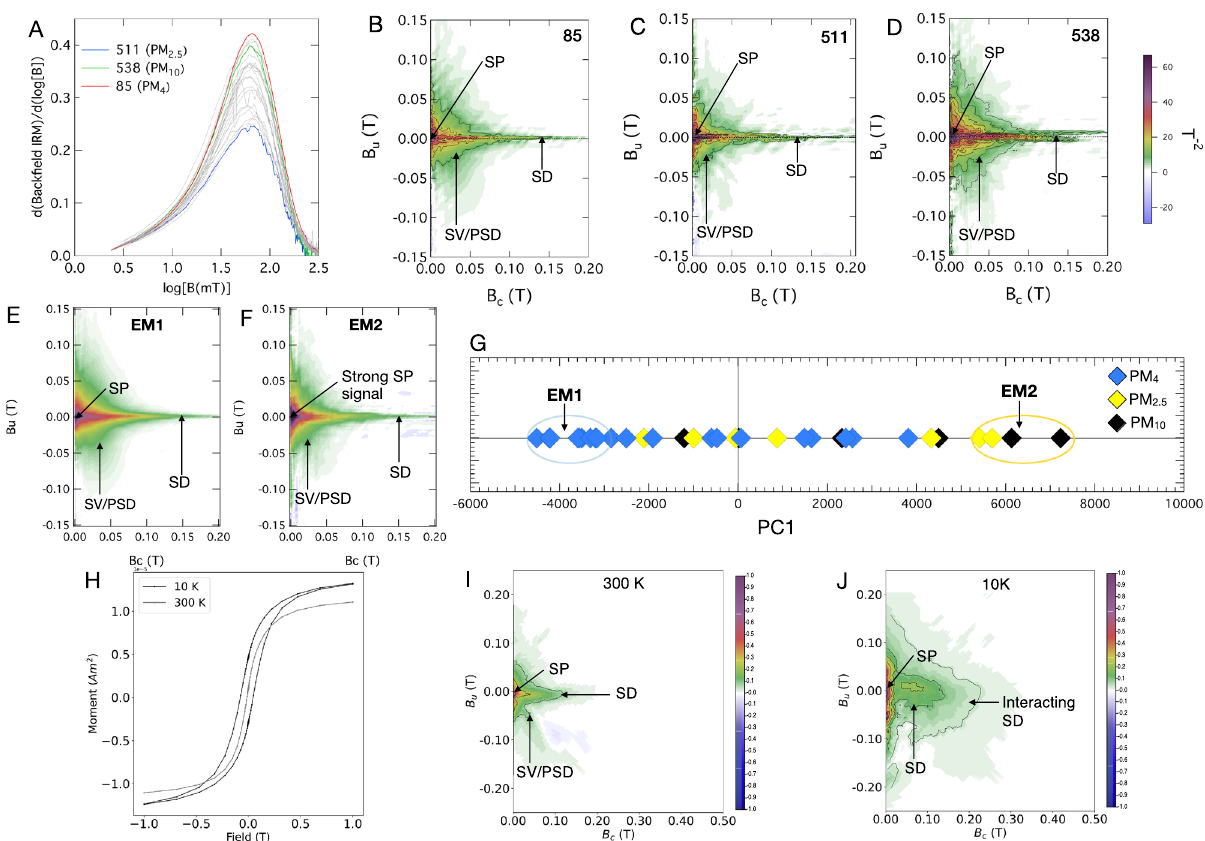
Figure 1. FORCs of representative different size-fractionated filters from the platform, and operator cabins. ( A ) shows log backfield remanent coercivity distribution of all air filter samples analysed ( B – D ) all samples show a broadly spread pattern that is indicative of SV/PSD state, and a SD low coercivity ridge. All samples were first normalised to a saturation magnetization ( M s ) value of 1. ( B ) also has a high coercivity (HC) ridge extending up to 200 mT. ( E , F ) shows the two members (EMs) extracted from FORC-PCA analysis 24 . ( G ) FORC-PCA score plot for mixing space between EM1, and EM2; diamonds are individual FORCs for each sample. ( H ) Low temperature hysteresis curve for sample 511 shows increases in remanence at 10 K vs 300 K. ( I ) Room temperature FORC measured on the MPMS, with coercivity ridge extending to about 150 mT ( J ) Low temperature FORC shows an increase in coercivity to 300 mT at 10